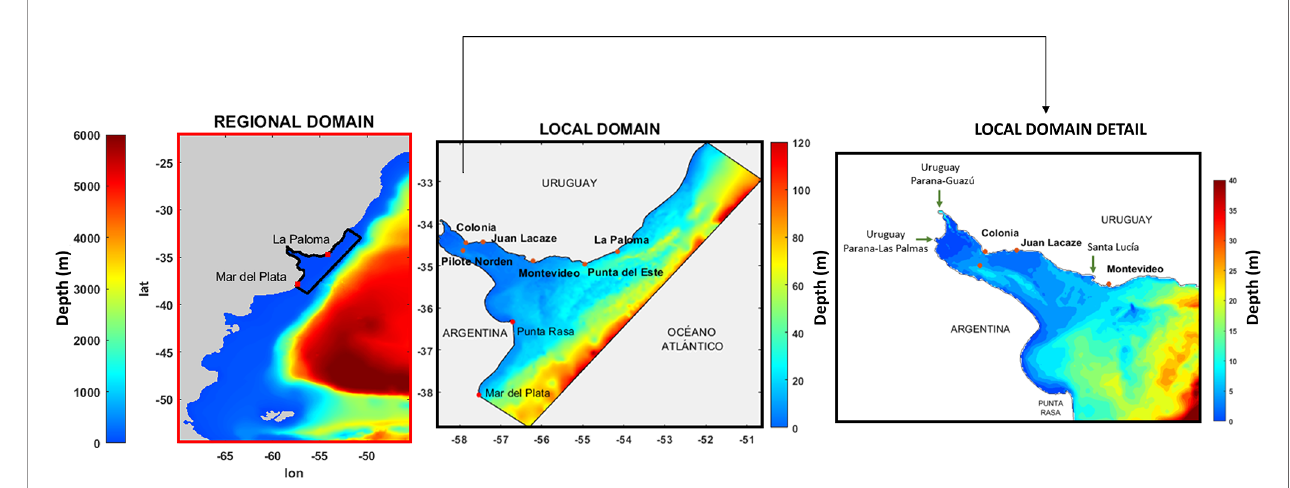
FIGURE 3 | Nested hydrodynamic models scheme used in this